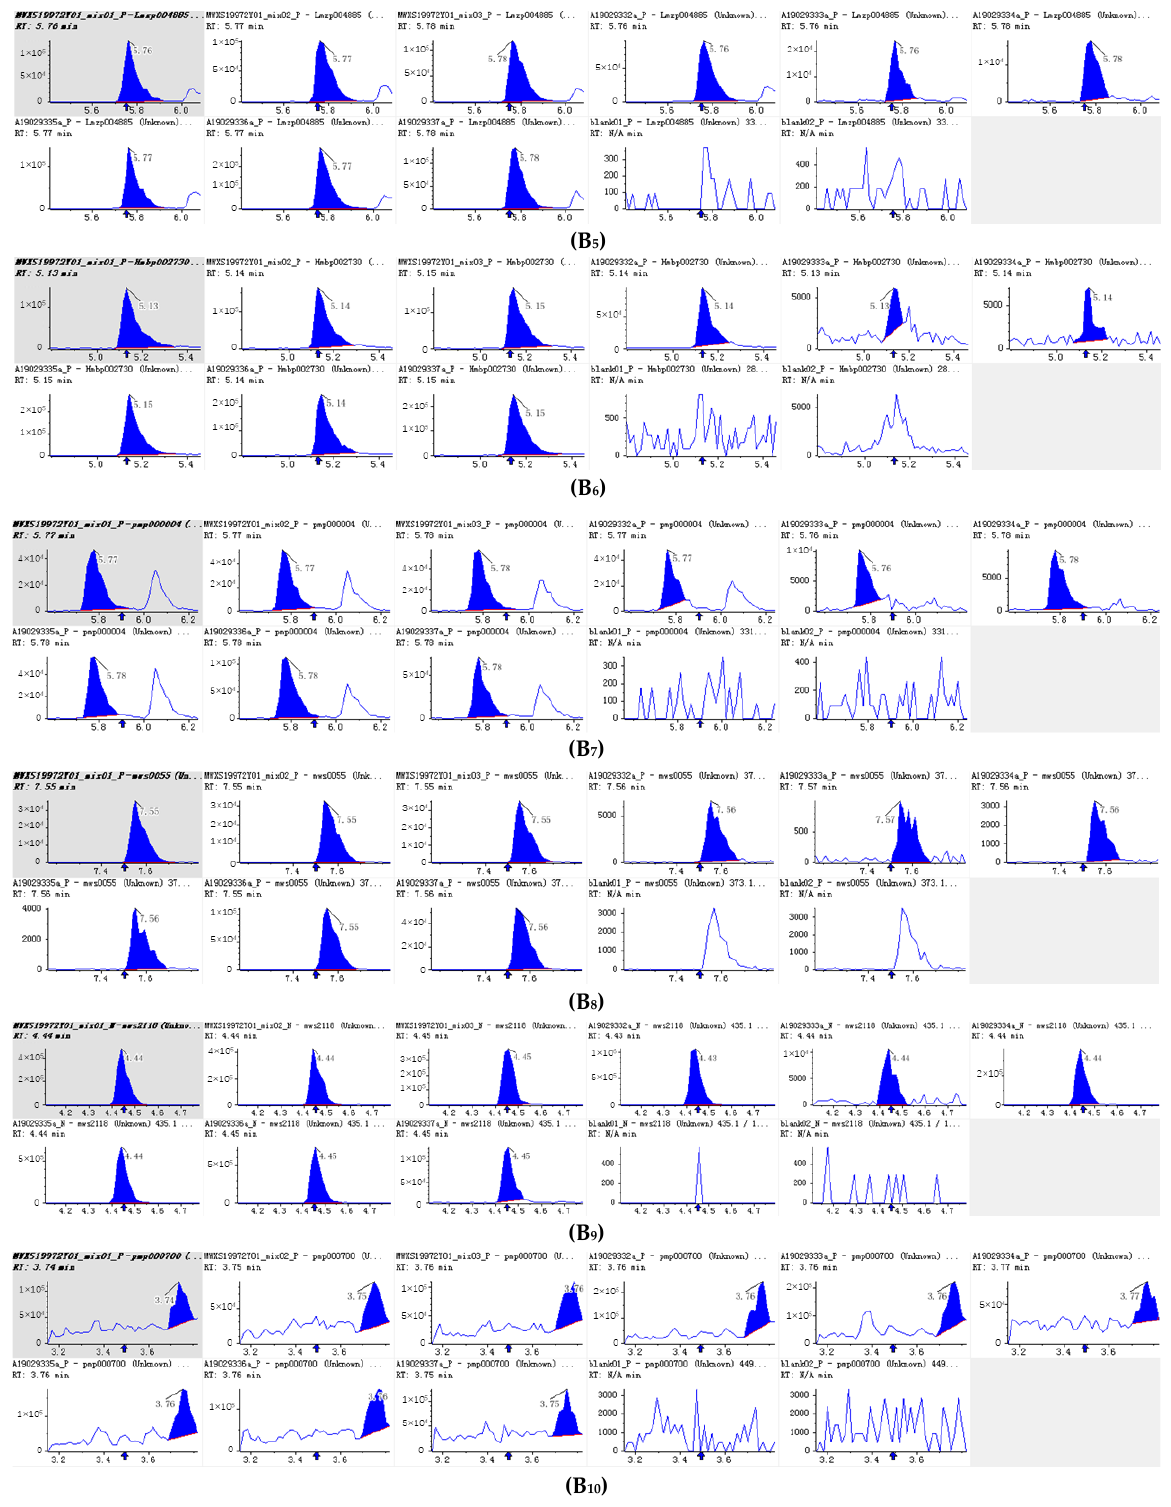
Figure 5. Integral diagram of Luteolin ( B 1 ), Hispidulin ( B 2 ), Diosmetin ( B 3 ), Taxifolin ( B 4 ), Tricin ( B 5 ), Isoscutellarein ( B 6 ), Jaceosidin ( B 7 ), Tangeretin ( B 8 ), Phloretin ( B 9 ) and Isoorientin ( B 10 ) quantitative analysis in PFDF.The abscissa is the retention time of metabolites (min), the ordinate is the ion current intensity of metabolites (cps), and the peak area represents the relative content of substances in the sample. The arrow in the figure indicates that the position of retention time corresponds to the RT value in the